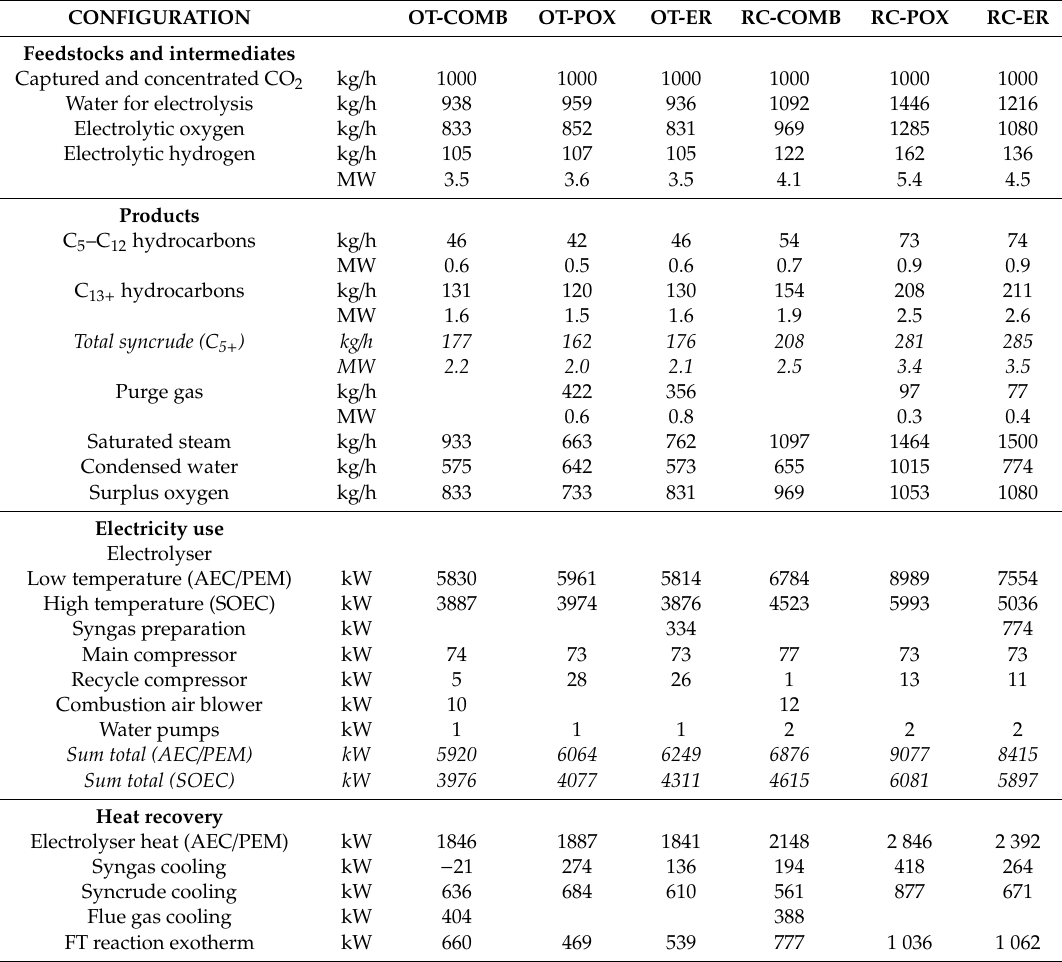
Table 3. Simulated mass and energy balances for the examined process configurations when syngas preparation step is operated at 900 ◦